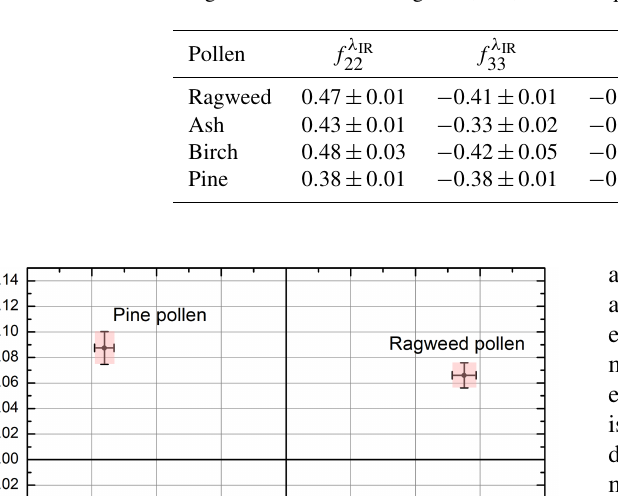
Table 2. Retrieved scattering matrix elements of ragweed, ash, birch and pine at a 177.5 ◦ scattering angle at wavelength λ IR .